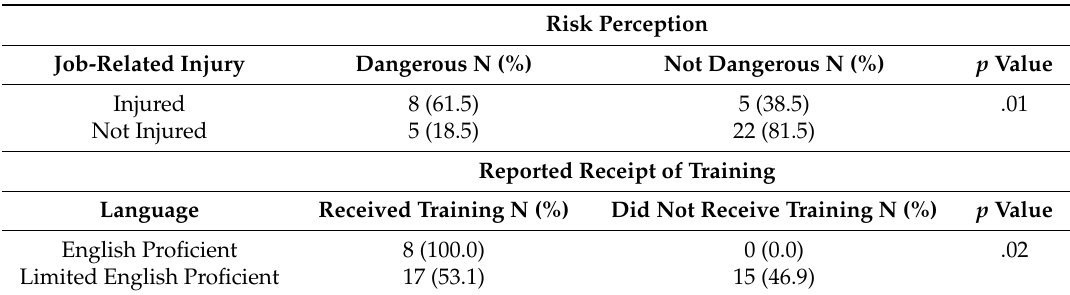
Table 2. Chi square tests of associations between study